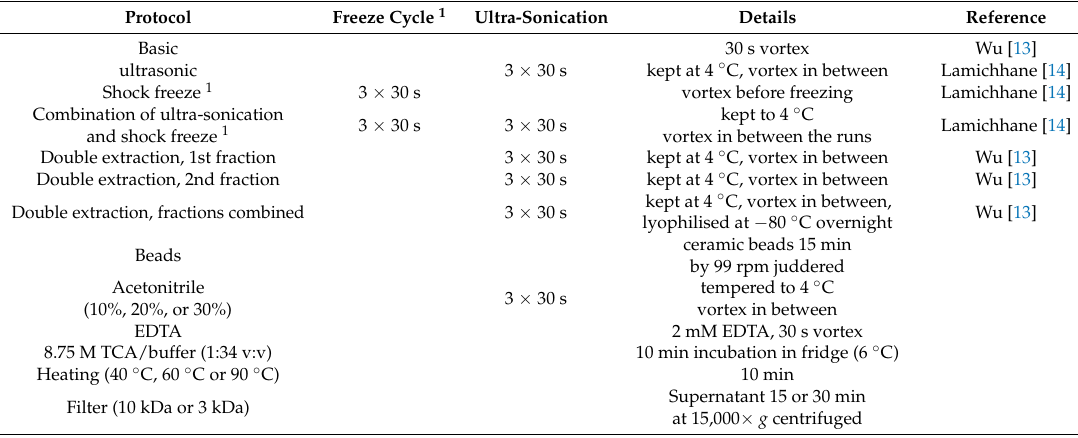
Table 1. Summary of the single-phase buffer extraction protocols used for the homogenized mice feces.